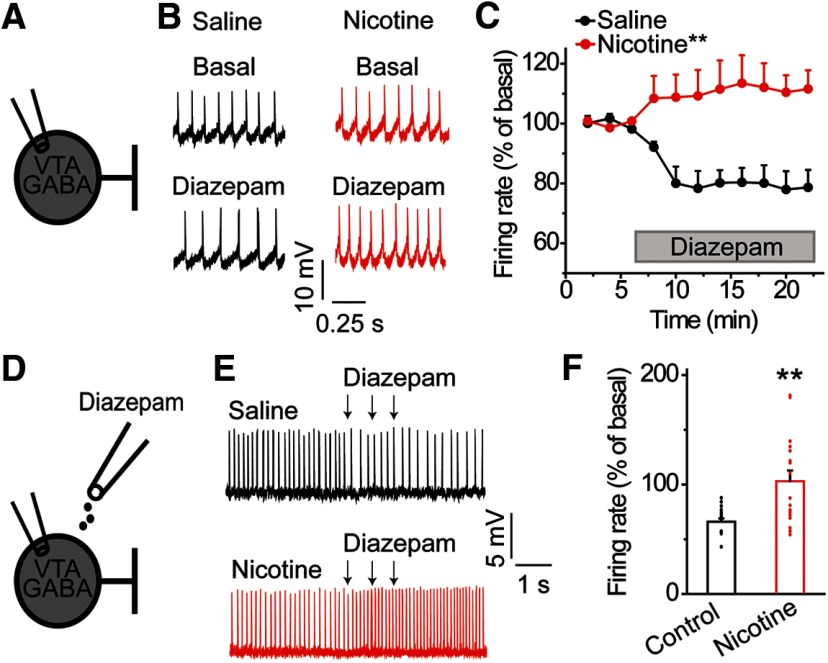
Diazepam increases the firing rate of VTA GABA neurons following acute nicotine exposure. A, Spontaneous firing rates of VTA GABA neurons were measured using the cell-attached configuration before and after bath application of diazepam. B, Representative recordings from VTA GABA neurons before and after bath administration of diazepam in the nicotine (red) and saline (black) groups. After nicotine pretreatment, bath applied diazepam increased GABA neuron firing rates in contrast to decreased firing in the saline group. C, In saline-treated controls, diazepam decreased the firing rate of VTA GABA neurons. In the nicotine-treated group, diazepam increased the firing rate of VTA GABA neurons; **p < 0.01, significantly different by ANOVA with repeated measures, n = 7, n = 8 cells/group, n = 4, n = 5 rats/group. D, Cell-attached recordings were performed on VTA GABA neurons to assess changes in firing in response to locally applied diazepam ex vivo. E, VTA GABA neurons from saline-treated animals (black) demonstrated a reduction in action potential firing when diazepam was focally puffed onto the recorded neuron. In contrast, VTA GABA neurons from nicotine-treated rats (red) often displayed enhanced firing to diazepam puff application. F, Focal puff application of diazepam decreased the firing rate of VTA GABA neurons in saline-treated controls. In nicotine-treated animals, puff-administered diazepam increased the firing rate of nearly half of all VTA GABA neurons recorded; **p < 0.01, significantly different by t test, n = 17 cells/group, n = 9, n = 11 rats/group.